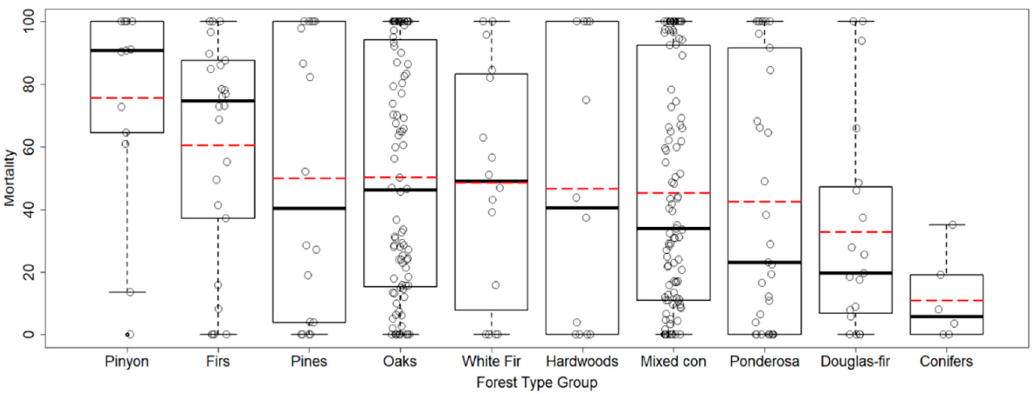
Figure 1. Distributions of observed fire-induced mortality as a percent of pre-fire, live tree basal area by forest type group, with mean (dashed red line), median (solid black line), quartiles (box ends), 5th and 95th percentiles (whiskers), and observations (open circles). Forest type groups arranged, left to right, from highest to lowest mean mortality.